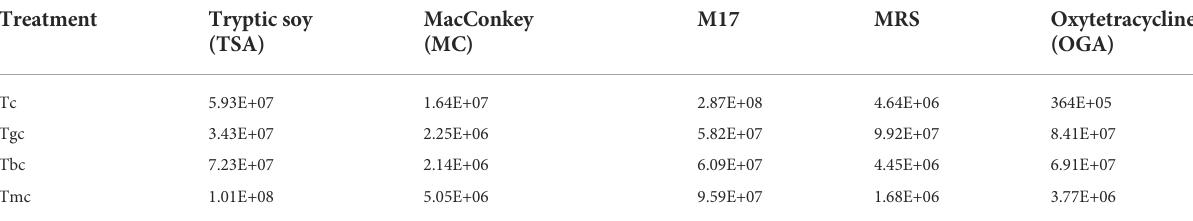
TABLE 5 Cumulative table showing colony forming units per gram on culturing media.